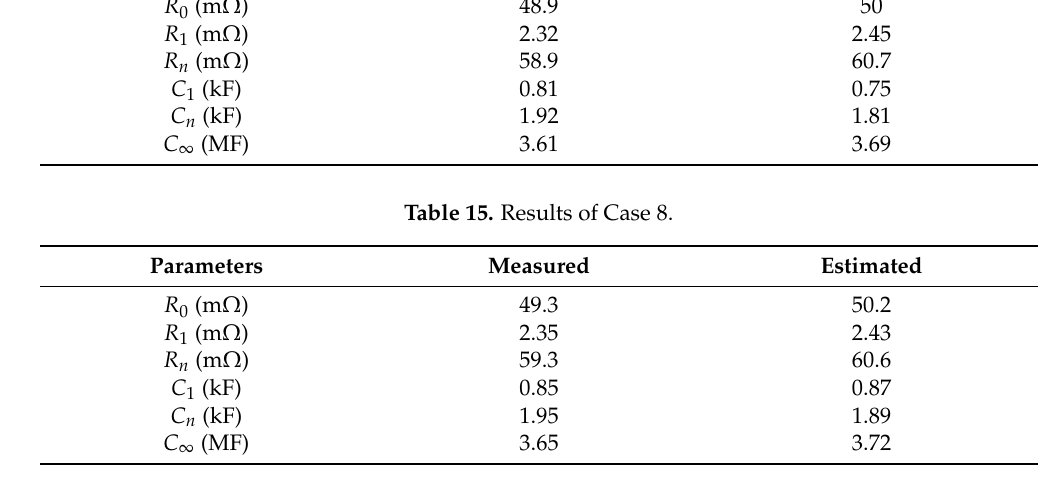
Table 16. Results of Case